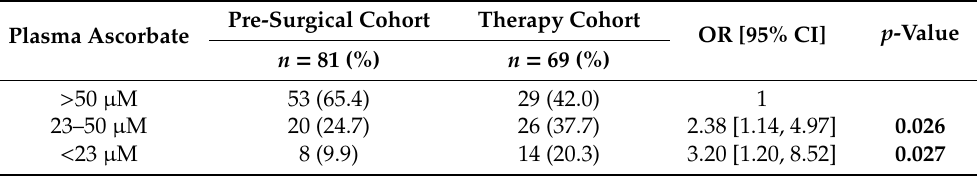
Table 2. Comparison of fasting cancer patient cohorts according to categories of plasma ascorbate. Pre-Surgical Cohort Therapy Cohort OR [95% CI] p -Value Plasma Ascorbate n = 81 (%) n = 69 (%)